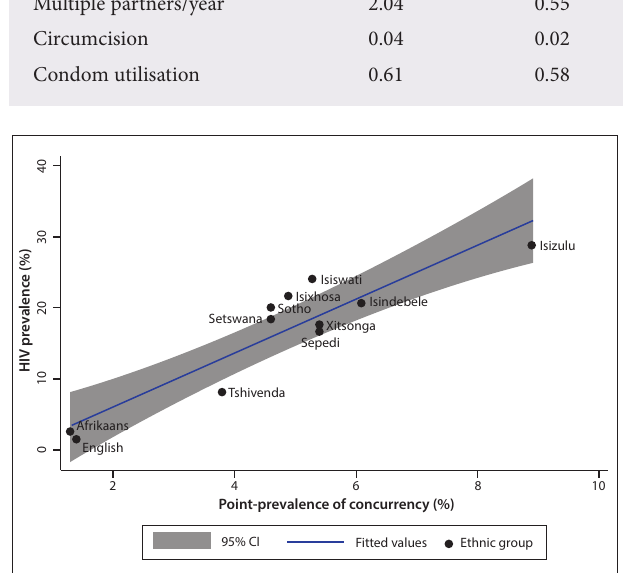
Table 2. Univariate and multivariate linear regression analysis of the relationship between HIV prevalence per language group and risk factors [2,3] Risk factor